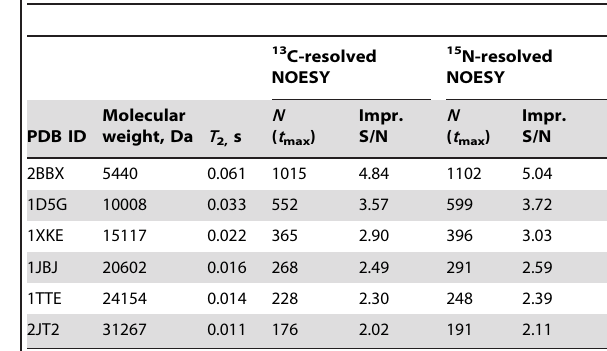
Table 2. Improvements in S/N for 13 C- and 15 N-resolved NOESY spectra at the optimal resolution calculated at t max =1.26 T 2